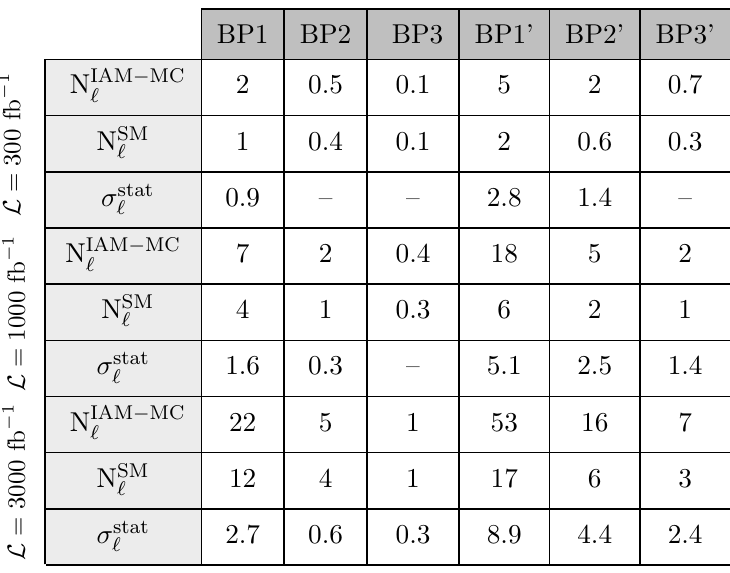
Table 3 . Predicted number of pp